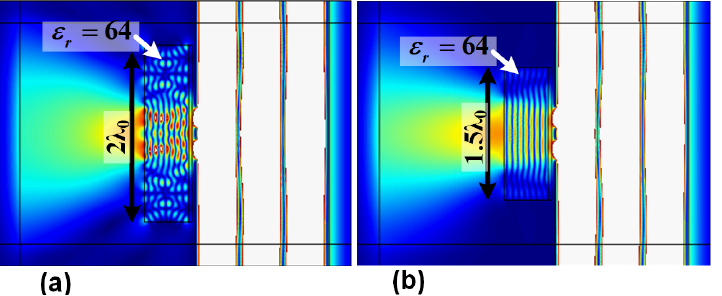
Figure 6. Projection of the two slits when the length of the proposed two-layer structure is ( a ) 2 λ 0 and ( b ) 1.5 λ 0 . and ( b ) 1.5 λ 0